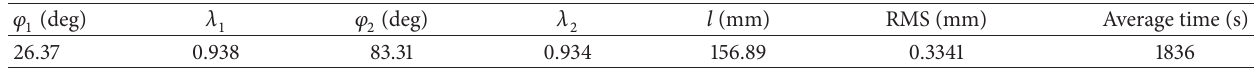
Table 6: The result of optimization.